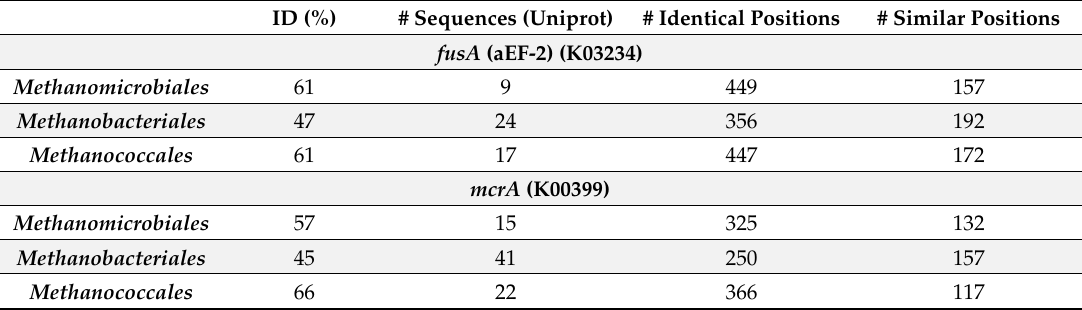
Table 2. Analysis of potential gene targets for the LAMP assay for detection of hydrogenotrophic methanogens in environmental